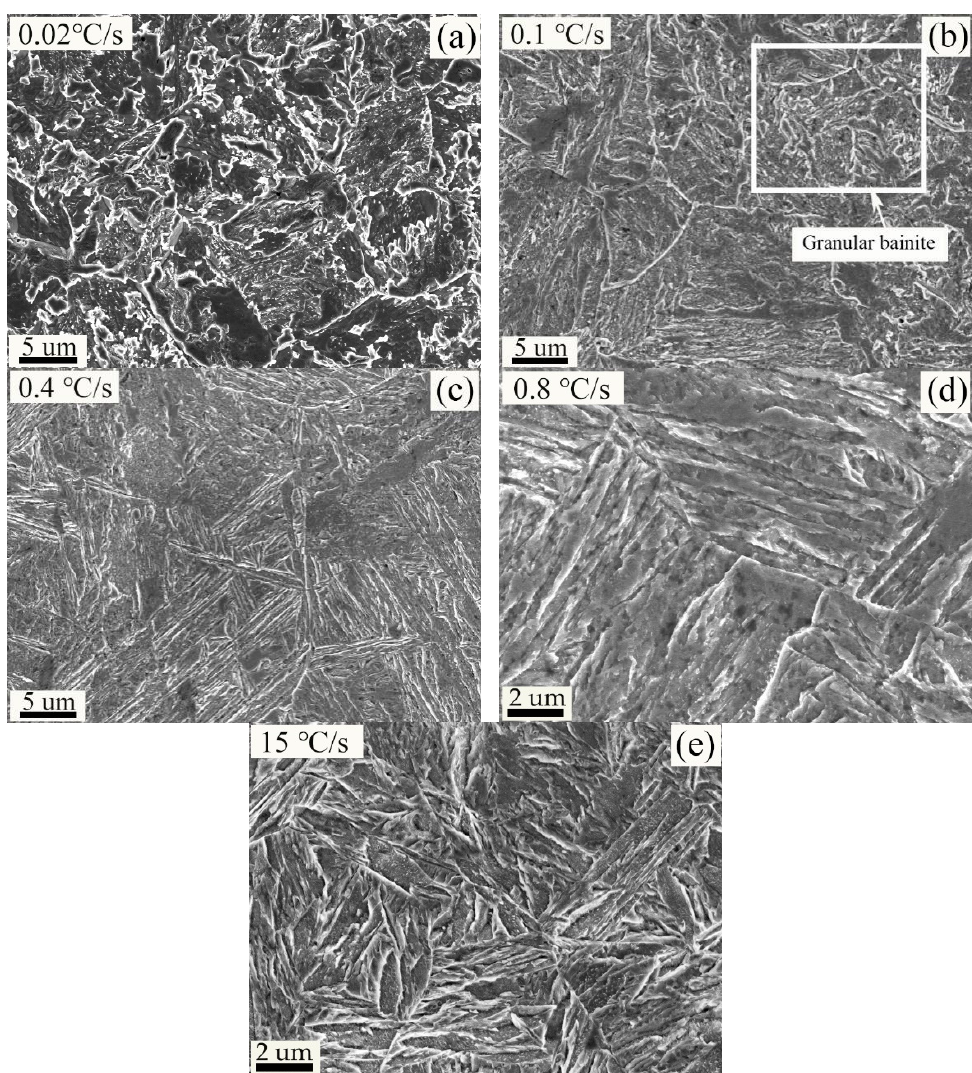
Figure 6. SEM micrograph of the matrix at the cooling rate of 0.02 °C/s ( a ), 0.1 °C/s ( b ), 0.4 °C/s ( c ), 0.8 °C/s ( d ) and 15 °C/s ( e ).